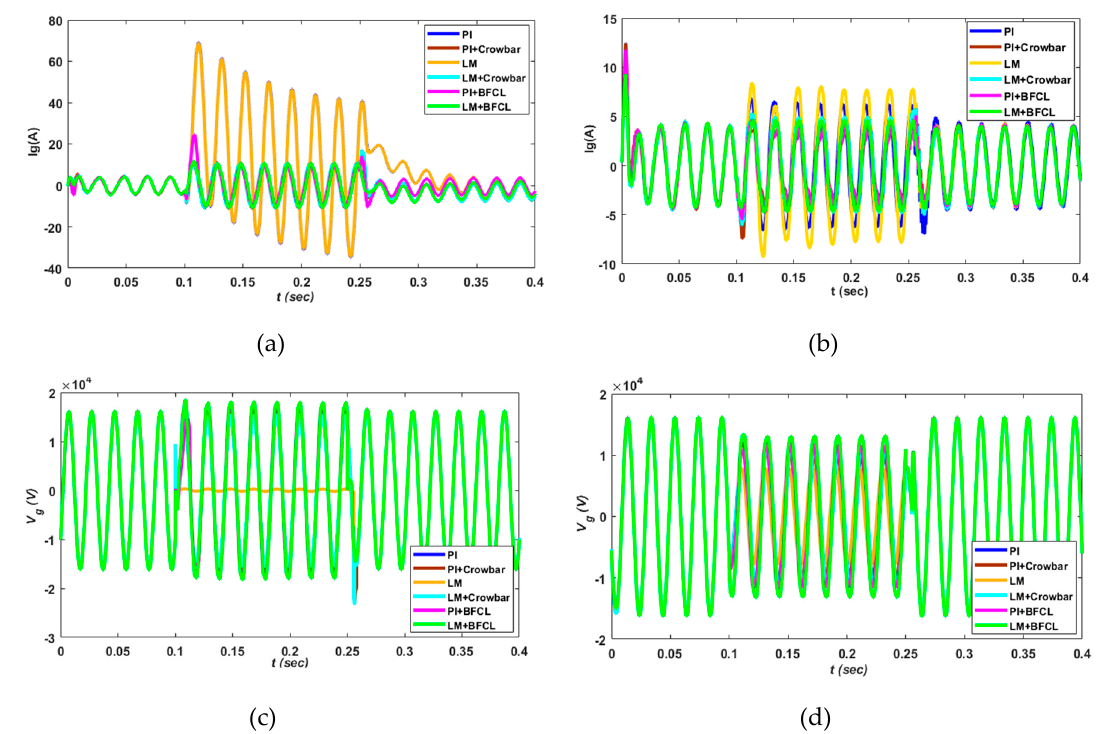
Figure 23. Grid current and voltage during the P-G fault (a, b) and the P-P fault (c, d) at 5-km from PCC.